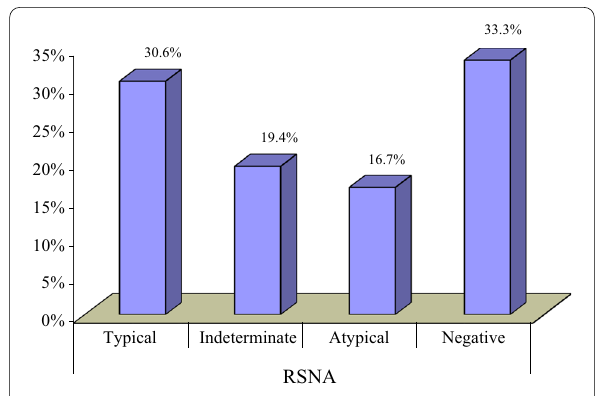
Fig. 5 Percentage of cases in each RSNA category